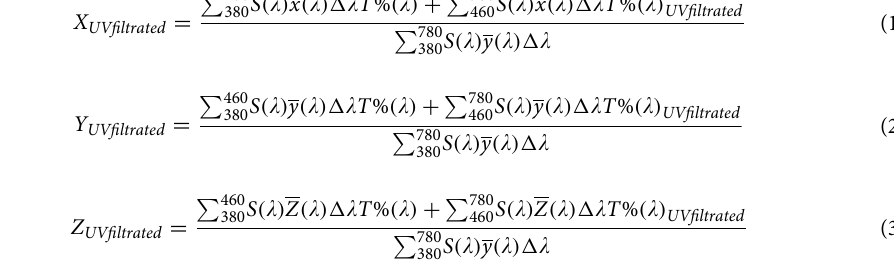
nated by optical transition 2 E g → 4 A 2 g in Cr 3+ ion according to the previous research 28 . The emission intensity of the pinkish-red spinel excited by ~ 535 nm radiation is close to that excited by ~ 380 nm radiation. It proves that visible light could also excite the pinkish-red spinel to produce strong red fluorescence, as a result, the color of the pinkish-red spinel becomes more vivid and brighter. Considering this circumstance, the color contribution from fluorescence is essential for the color measurement of the pinkish-red spinel. Color analysis. To study the effect of a light source on spinel color, the color data of the spinel samples were measured by using an X-Rite Ci-7800 spectrophotometer with a background of Munsell N9 color chip for it is closed to gemstone common presentation in the jewelry industry. The whole experiment was conducted in the